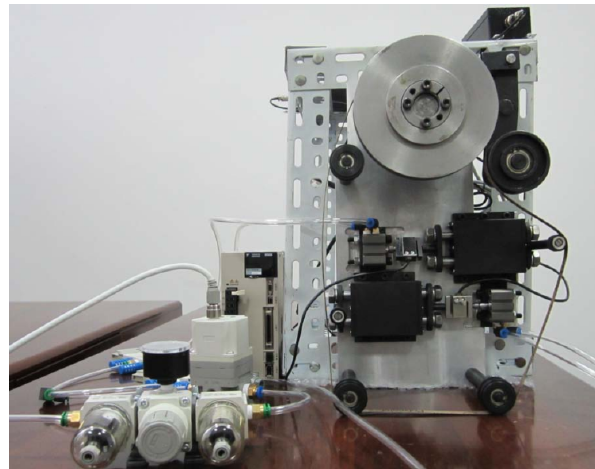
Figure 3. Physical drawing of the adaptive belt tool